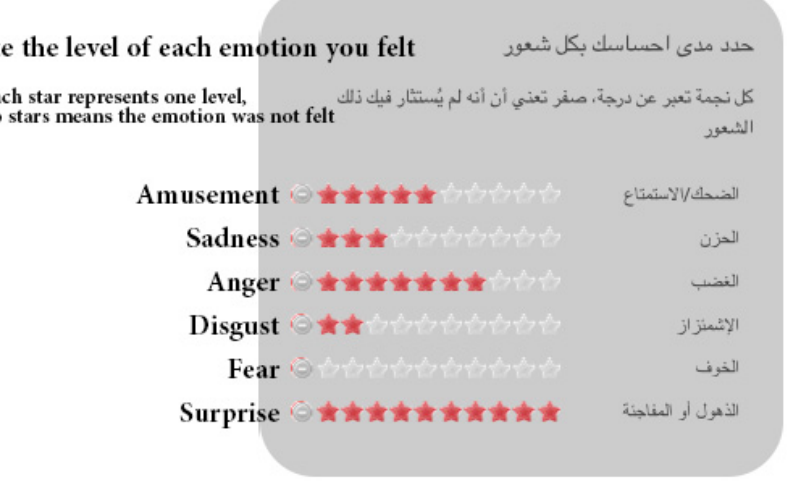
Figure 2. An example of rating emotions after watching a